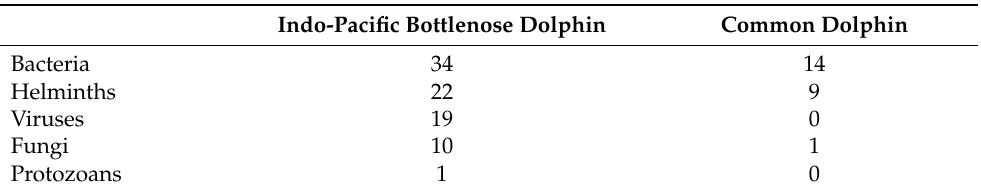
Table A6. Number of dolphins with infectious inflammation, according to pathogen, during the St Vincent Gulf Bioregion, South Australia, study in 2009–2020.